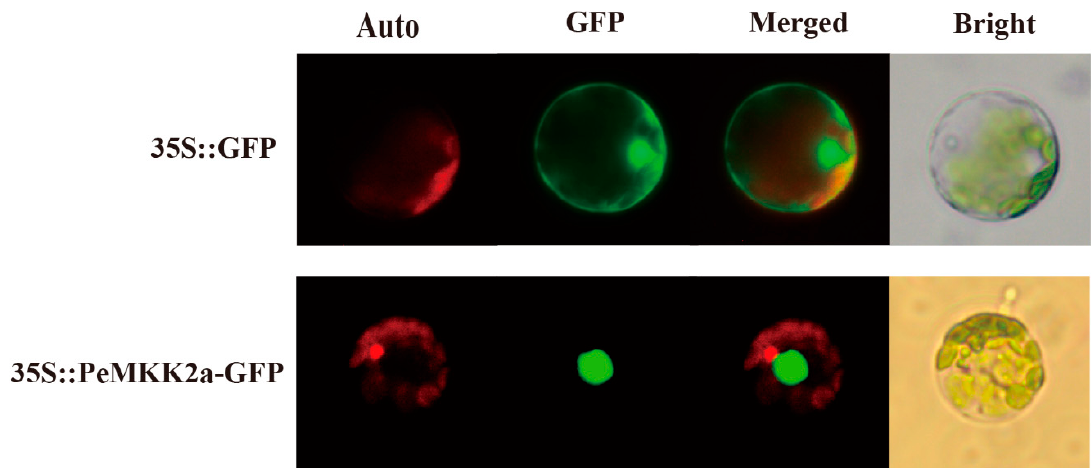
Figure 4. Subcellular localization of the PeMKK2a protein in poplar protoplast. Chlorophyll autofluorescence (auto), green fluorescence protein (GFP), merged and bright images are shown. (Scale bar 10 μ m. The 35::GFP fusion was used as a positive protein control).